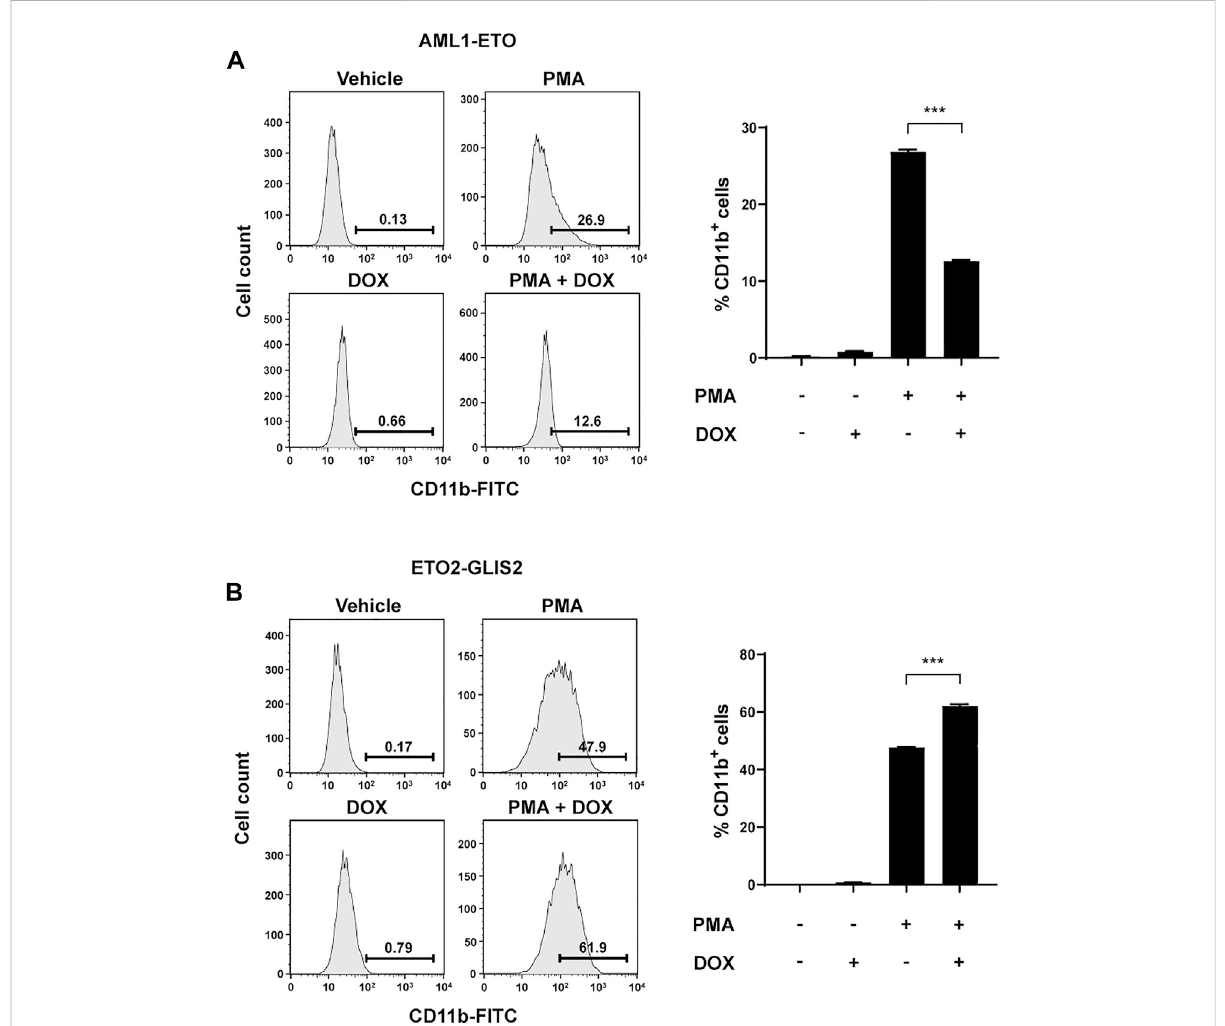
FIGURE 6 Opposite functions of AML1-ETO and ETO2-GLIS2 in regulating myeloid differentiation of U937 cells. (A) AML1-ETO inhibits myeloid differentiation of U937 cells. (B) ETO2-GLIS2 prompts this differentiation. Phorbol-12-myristate-13-acetate (PMA) was used as an inducer of differentiation of U937 cells to monocyte/macrophage lineages, and CD11b was used as a cell-surface marker. Left panel shows a representative fl ow cytometry result, and the right panel shows quanti fi cation and statistical analysis. Data are presented as means ± SD of three separate experiments; two-tailed t -test; *** p <